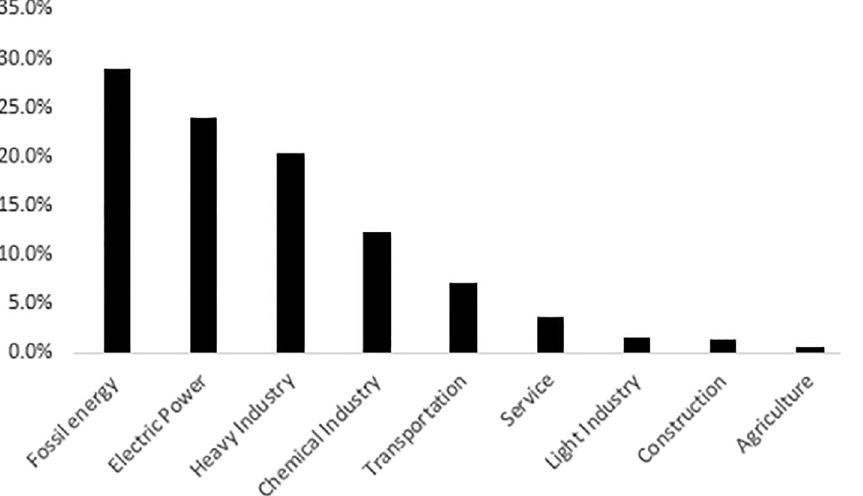
Fig 3. Proportion of carbon emissions in nine